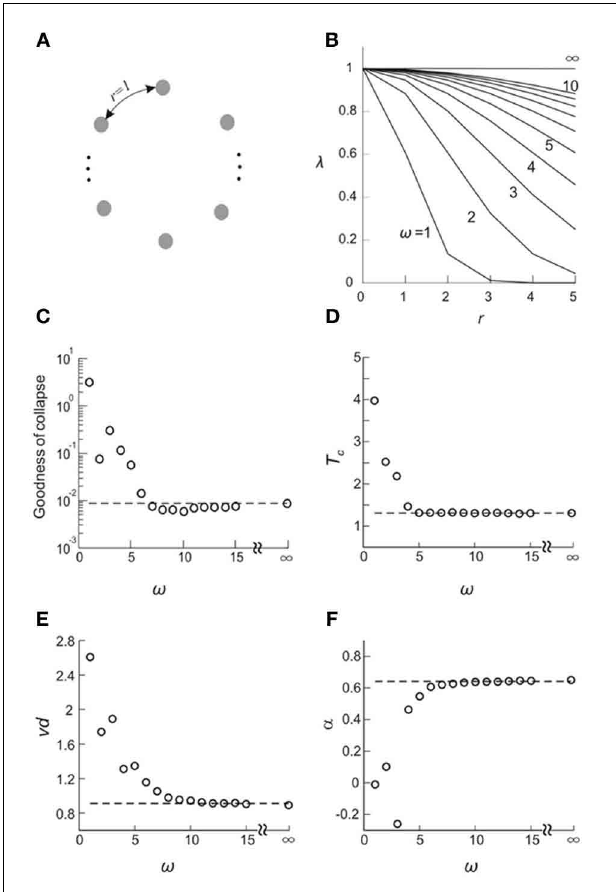
FIGURE 8 | Validating the FSS method by a simple model. (A) All elements are configured in a ring and the distance between any adjacent elements is 1. (B) the covariance of the hidden variables in the DG model, λ , is plotted as a function of the distance, r , that separates corresponding elements for different choices of the standard deviation of a Gaussian function, ω . (C–F) Goodness of collapse, T c and critical exponents measured for various systems are plotted against ω (open circles). In all systems, λ max and mean event rate were set such that when ω = ∞ , the average covariance and the event rate match what we empirically observed for Monkey 1. Corresponding results obtained from actual data for Monkey 1 (averaged across four sub-groups) are shown for comparison (broken lines).